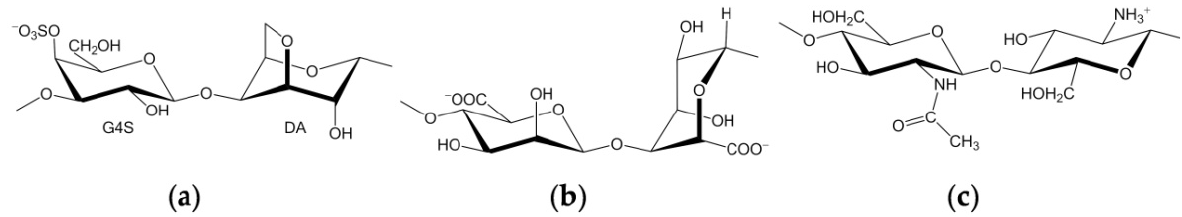
Figure 1. Structural formulas of polysaccharides from marine hydrobionts—( a ) κ ‐carrageenan, ( b ) alginate, and ( c )